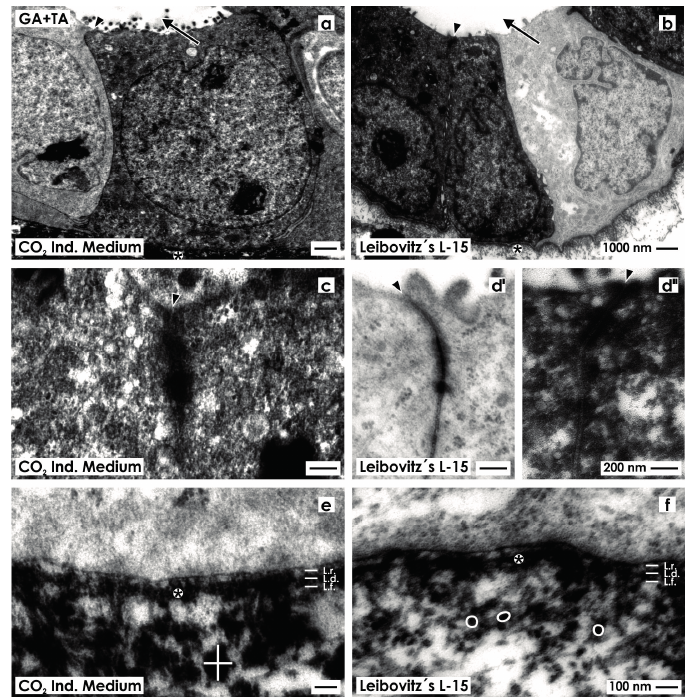
Figure 5. Transmission electron microscopy of renal tubules generated in CO 2 Independent Medium ( a , c , e ) or Leibovitz’s L-15 Medium ( b , d , f ) after fixation in GA solution containing tannic acid (TA). ( a , b ) Generated tubules show a polarized epithelium with a lumen (arrow) and a basal lamina (asterisk). In contrast to previous series light and dark cells can be seen; ( c , d ) Between the luminal and lateral plasma membranes a typical tight junction (arrow head) is established; ( e , f ) The basal lamina consists of a lamina rara (L.r.), lamina densa (L.d.) and lamina fibroreticularis (L.f.). At the interstitium fibers are linked to each other via massive (white cross; diameter 150 nm), respectively, small (round white label; diameter 36 nm) thickenings resulting in a